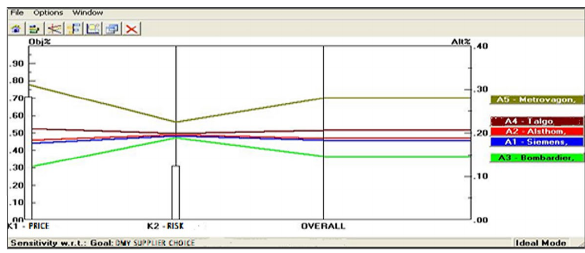
Figure 6. Performance sensibility analysis